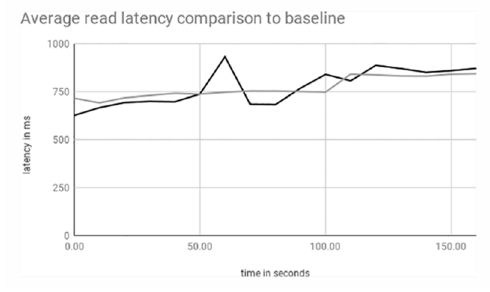
Figure 19. Average read latency of scaled cluster versus the baseline, single shard cluster.